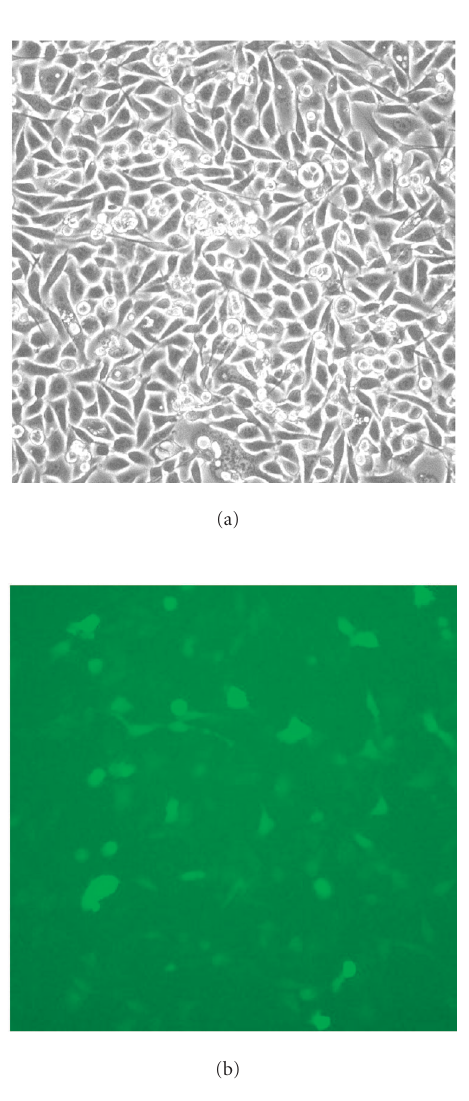
Figure 3. Infection of PC3 prostate cancer cells with a human- ised Bv expressing EGFP from a hybrid CAG promoter. Phase image of infected cells (a) after 24 hours indicates confluency of cultures while fluorescent image (b) confirms high infectiv- ity (at > 100particles/cell) of the tumour cells. After a further 24–48 hours more than 90% of the tumour cells express EGFP.